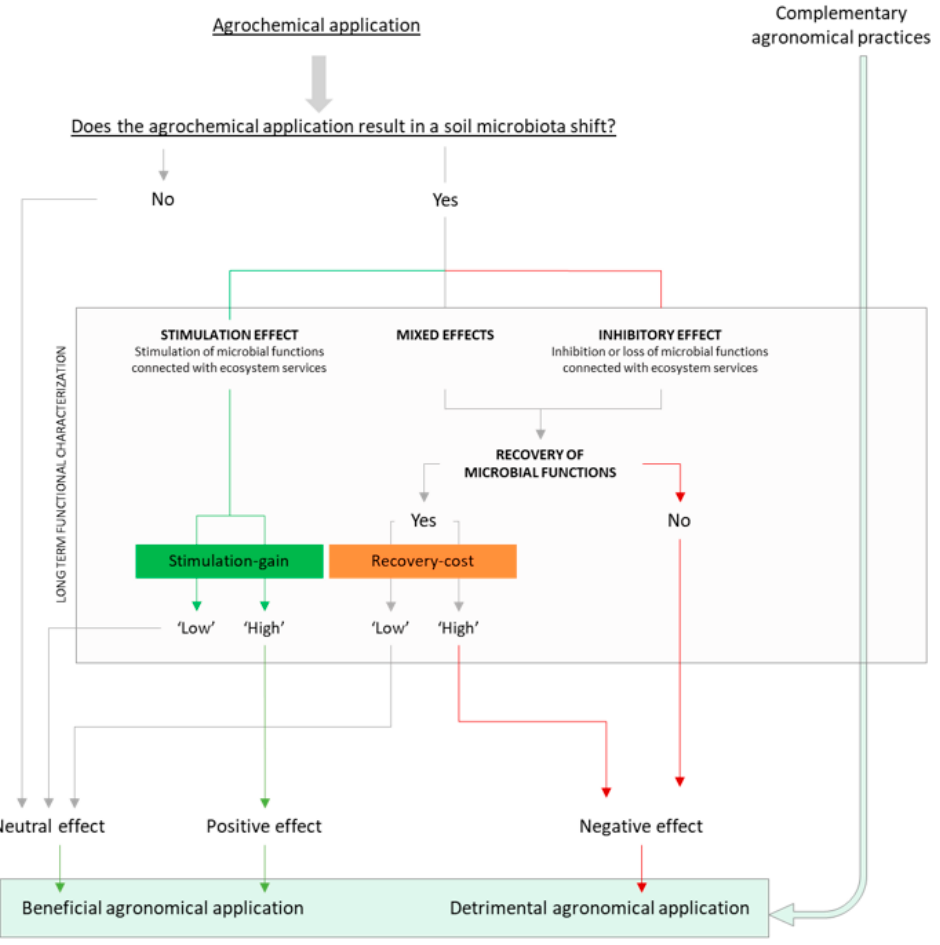
Figure 2. Model for the assessment of soil microbiota disturbances and in the agroecosystem.